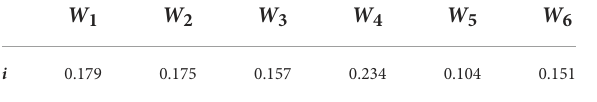
TABLE 10 The Hamming distance between PFNs and positive ideal points.